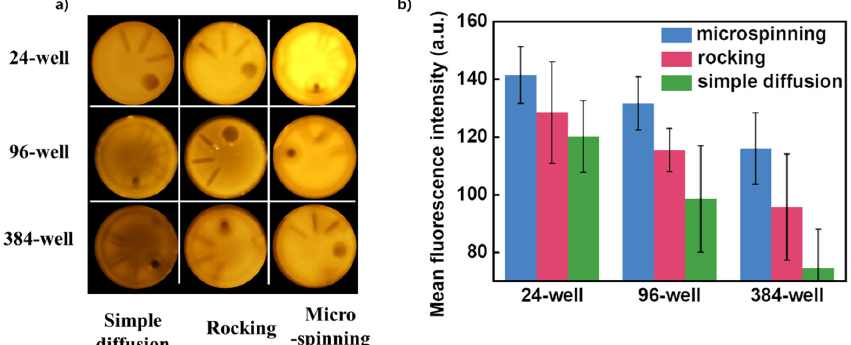
Figure 5. The comparative results of bioassay performance using a variety of mixing methods. ( a )Fluorescenceimagesoftherepresentativebeadimagefromeachexperimentalgroup. ( b )Quantitative analysis of reaction e ffi ciency based on fluorescence intensity from each